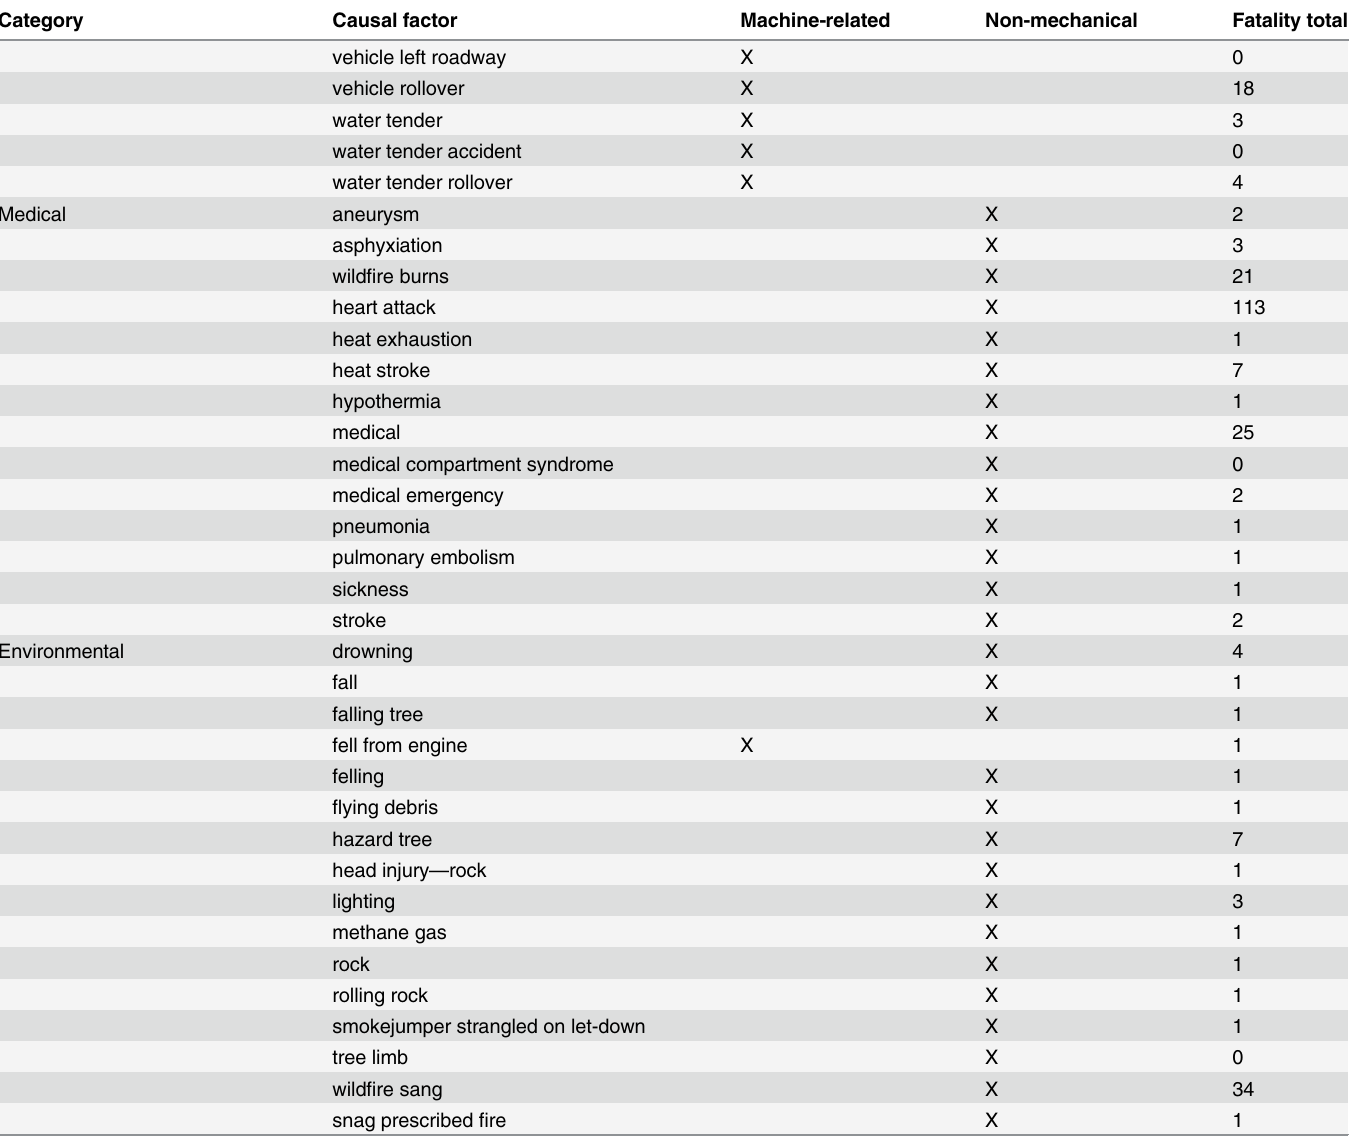
Rates of fatal injuries per 100,000 full time equivalent workers differed among occupations = 110.4, p < 0.001). Fire fighting, used as a proxy for resource management techniques (F 4,32 construction equipment operation, and animal production were not significantly different, with rates of 5.6, 12.1, and 15.6 respectively (Fig 1). Crop production had a higher rate of fatal injury than animal production, fire fighting, and construction equipment operators, with 28.8 fatal injuries per 100,000 full time workers. Logging had the highest rate at 97.3. Both